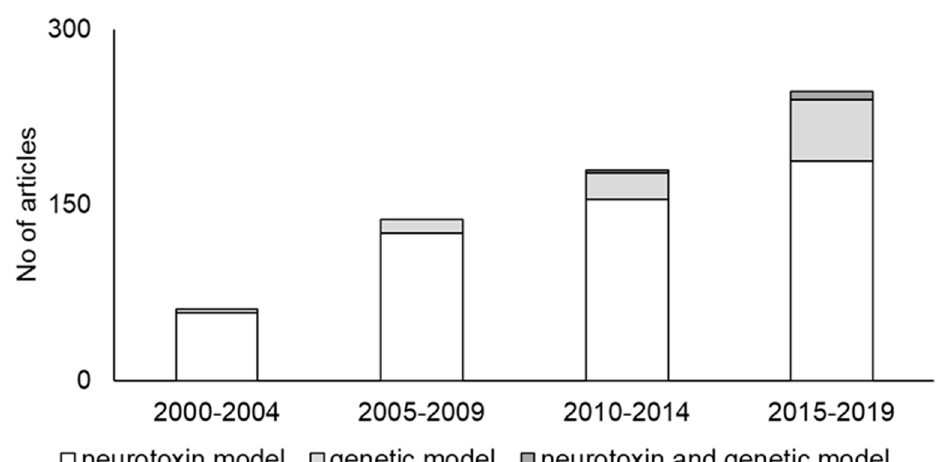
Figure 2. Trends in PD animal models. The number of articles gradually increased.